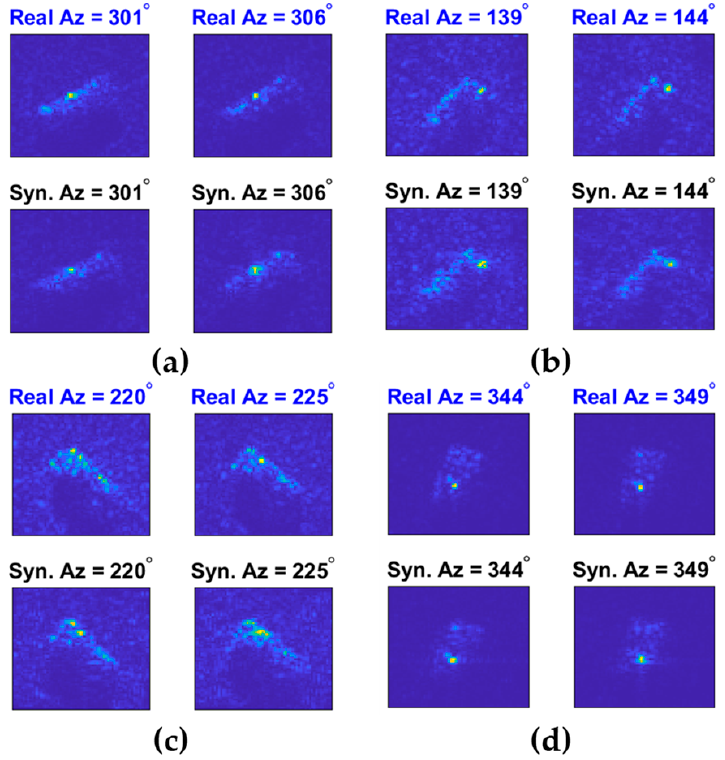
Figure 4. The real SAR image samples and the synthetic images obtained via interpolation (the synthetic samples at Az = θ ° are obtained from the real ones corresponding to Az = θ ° + 5°). ( a ) 2S1; ( b ) BRDM2; ( c ) BMP2; ( d ) ZSU23-4.